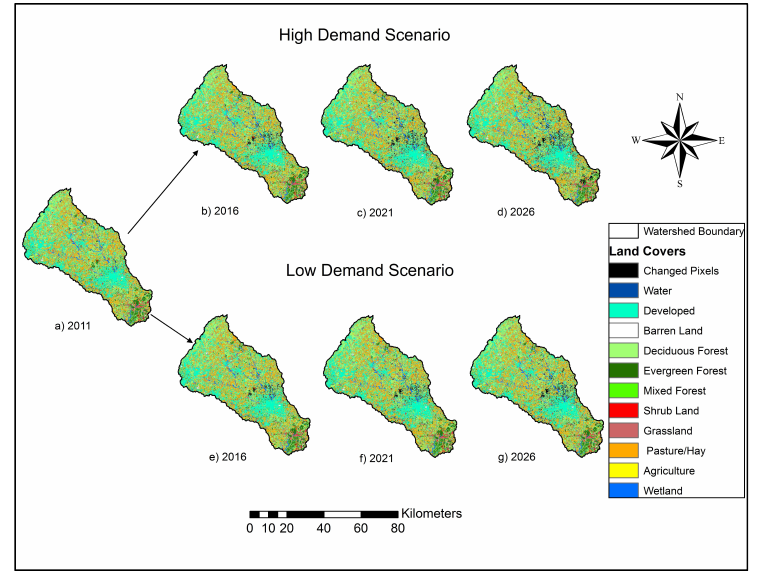
Figure 7. Land use changes under high and low demand scenarios for wood pellet production.